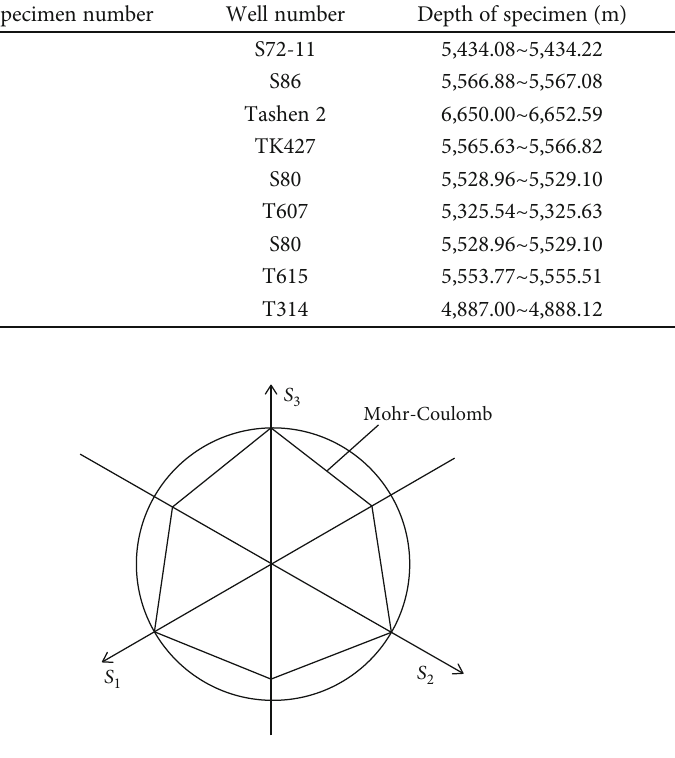
Figure 2: Mohr-Coulomb yield surface of the deviatoric stress pro fi le.